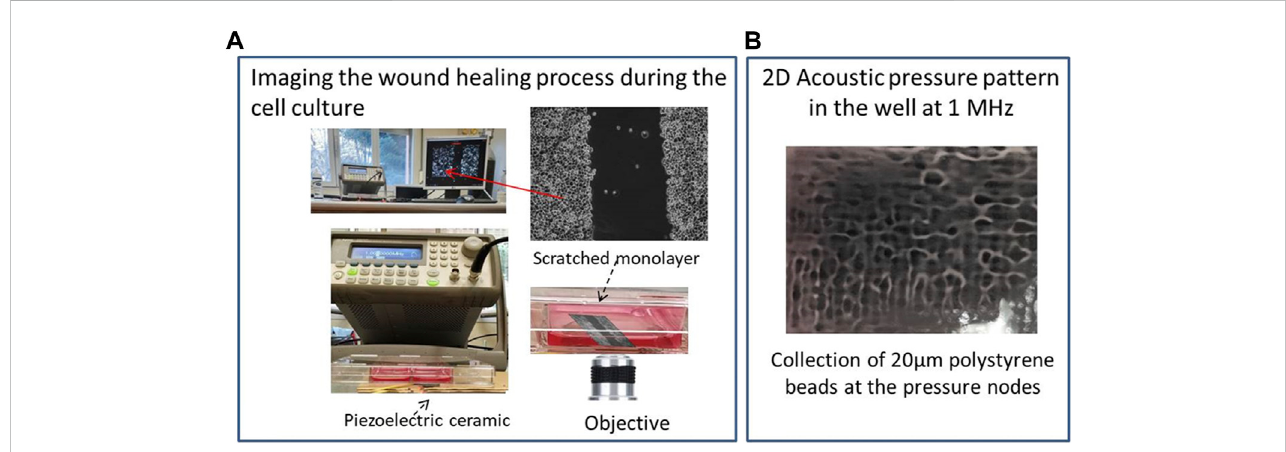
FIGURE 1 (A) Experimental setup including the ultrasound generator, transducer, microscope inside the incubator and image processor; (B) Acoustic pressure patternestablishedatf=1.003 MHzinthewelldirectlylocatedovertheultrasonicactuator.Polystyrenebeads(20 µm)collectatthepressurenodes,drawing this